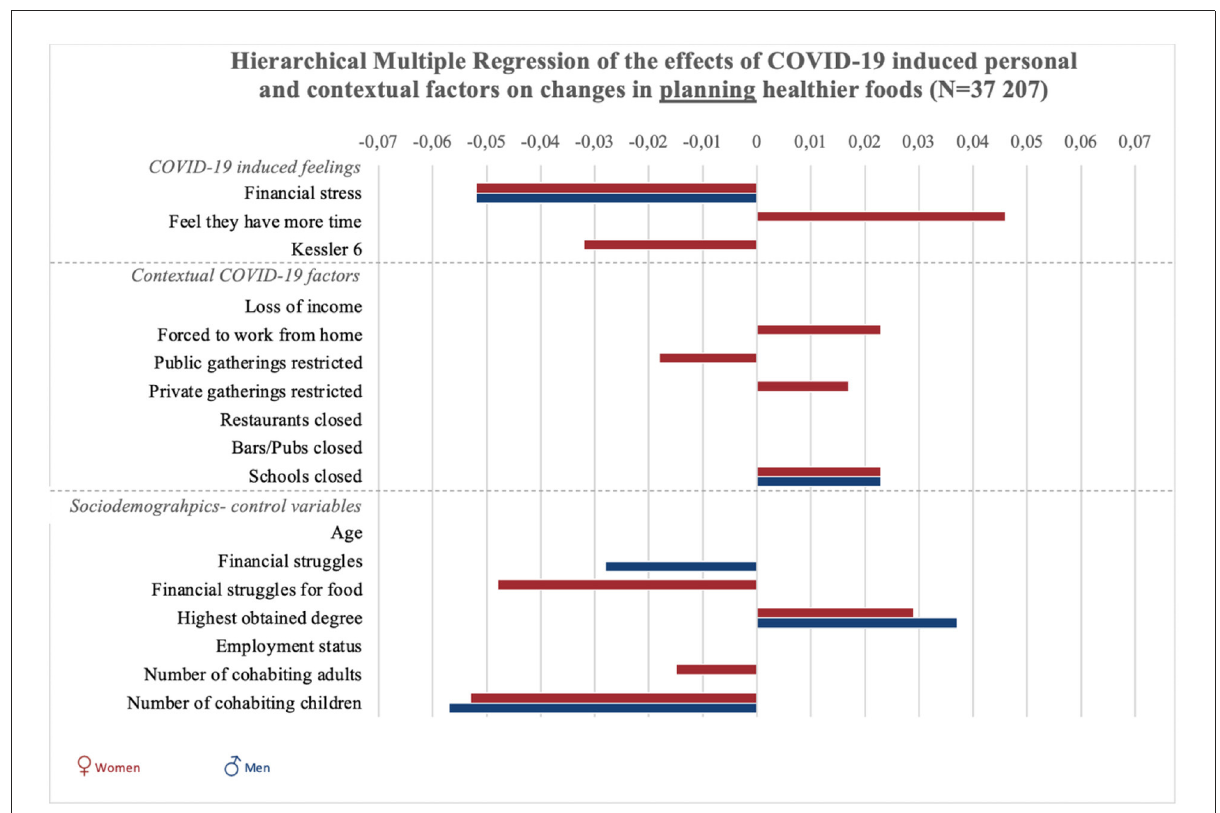
FIGURE1 Graphic summary of the significant relations between personal, contextual and sociodemographic variables and changes in planning healthier foods during COVID-19. We report beta-values only for significant relations in models 2 for planning healthier foods. Bars to the right indicate improvement in food planning, bars to the left indicate decreases in planning healthy